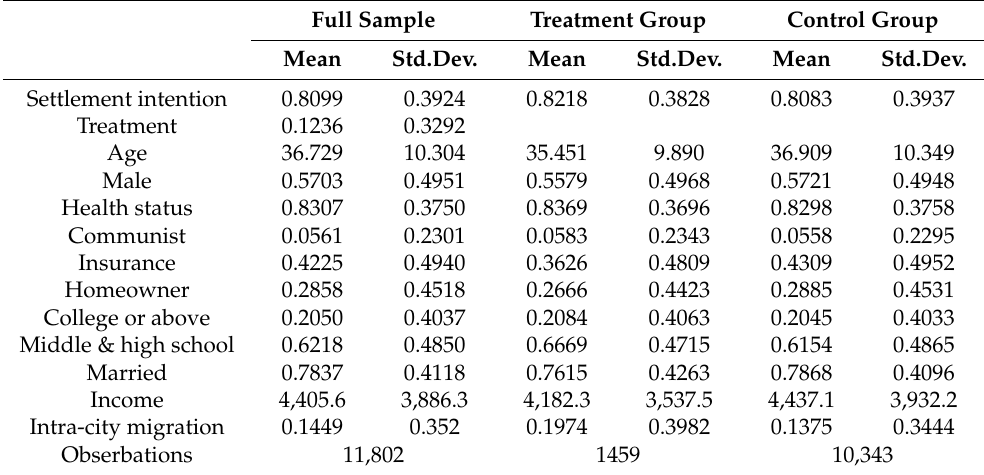
Table 1. Summary